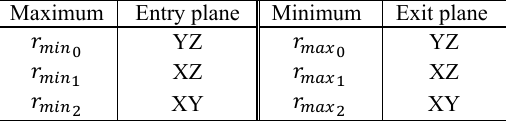
Table 1. Determination of entry and exit planes of a node